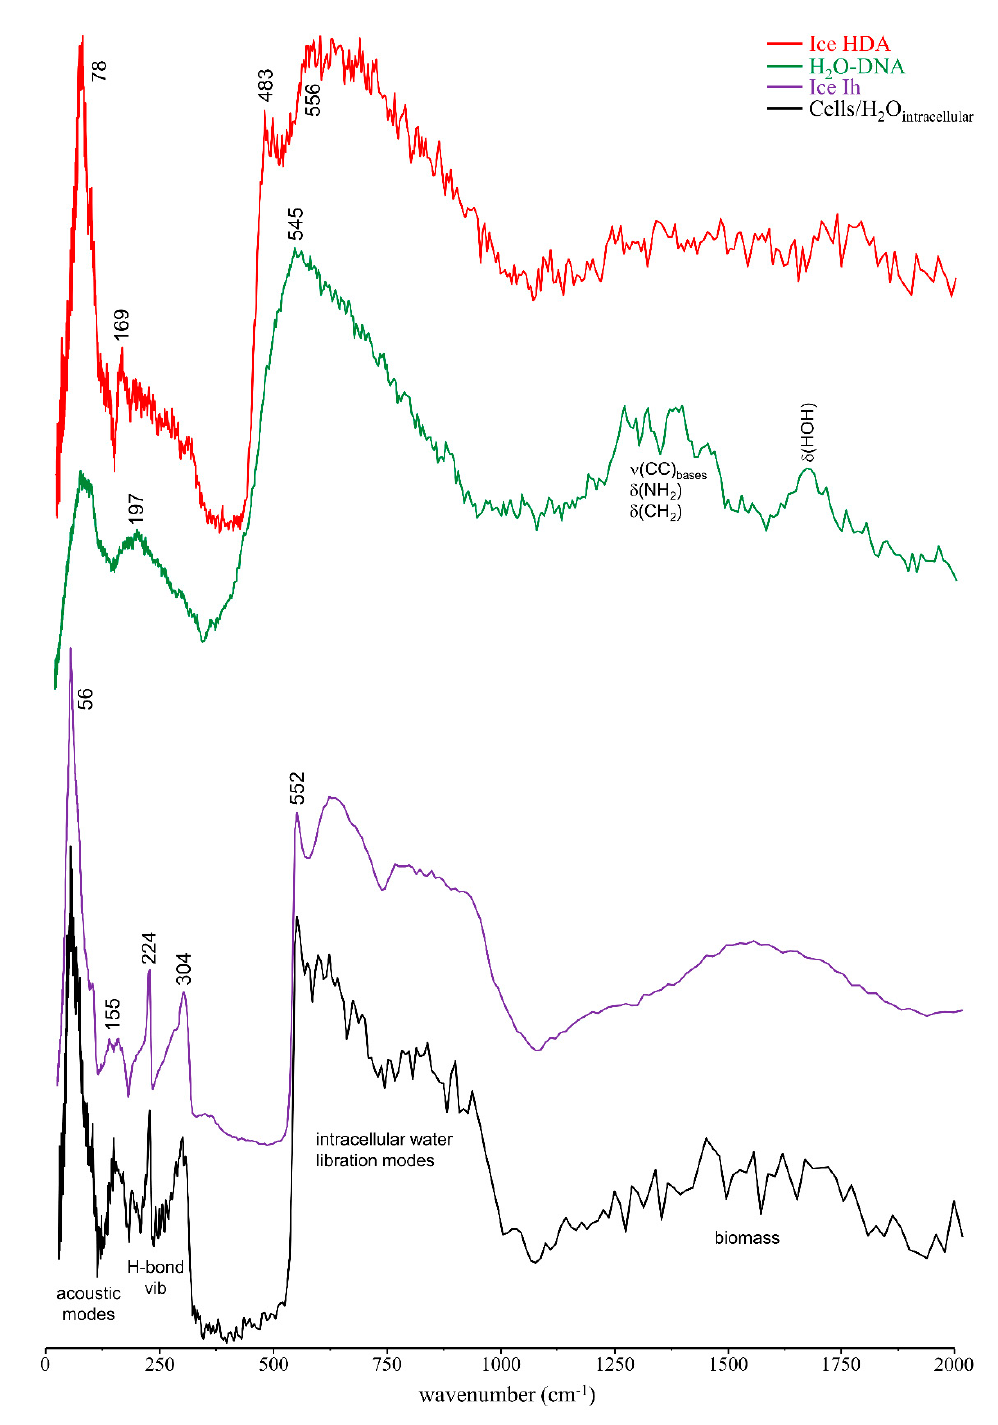
Figure 4. INS spectra (at 10 K) of H 2 O-DNA hyd and human breast cancer cells (MDA-MB-231) [15]. The INS data for hexagonal ice (Ih) and high density amorphous ice (HDA) [52,53] are also shown for comparison.